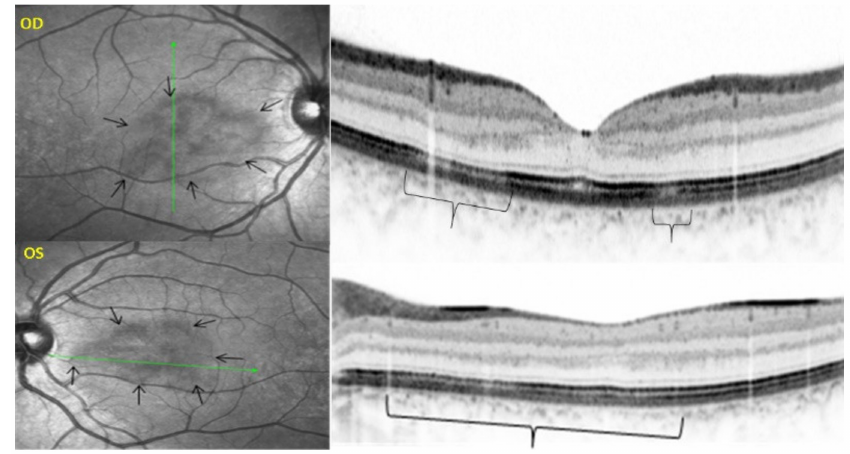
Figure 32. AMN. NIR-R, SD-OCT, FAF, FA, and ICGA images at first presentation. NIR-R and SD-OCT images: NIR-R imaging shows hyporeflective petal-like oval areas in the macular region (arrows) in corresponding on SD-OCT to a reduction of the signal of the IZ (brackets). In OD, the reduction of the signal is limited to two segments of the outer retina, while in OS, it comprises the whole outer retinal section corresponding to the hyporeflective infrared